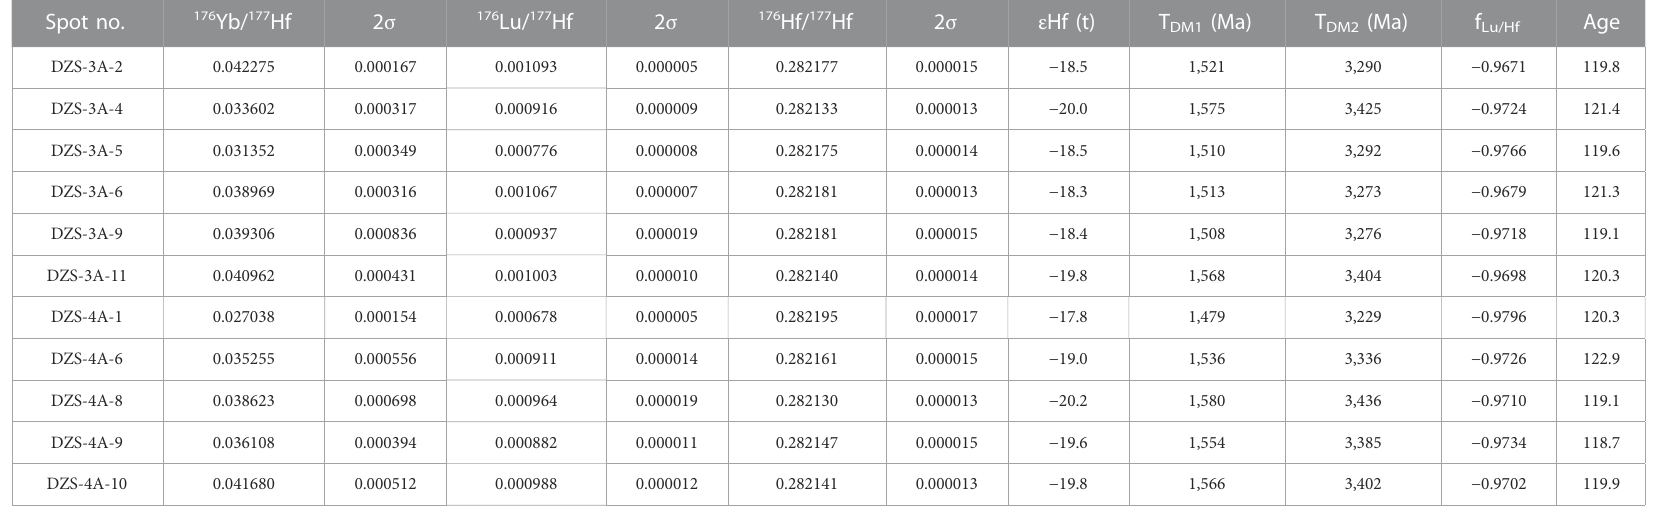
TABLE 4 Zircon Hf isotope data for the rhyolite porphyry and Dazeshan biotite granite. Spot